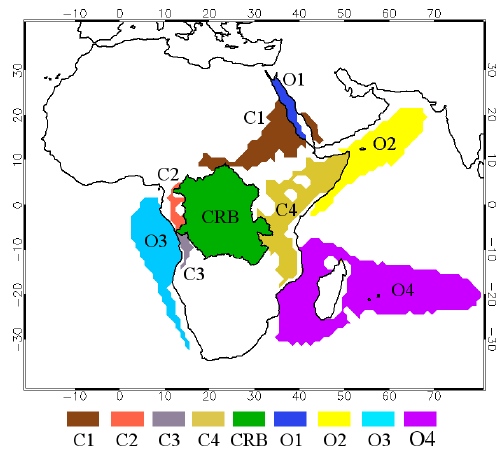
Figure 6. Continental moisture sources for the CRB: C1, C2, C3, C4, and the CRB itself; oceanic moisture sources: O1, O2, O3, and